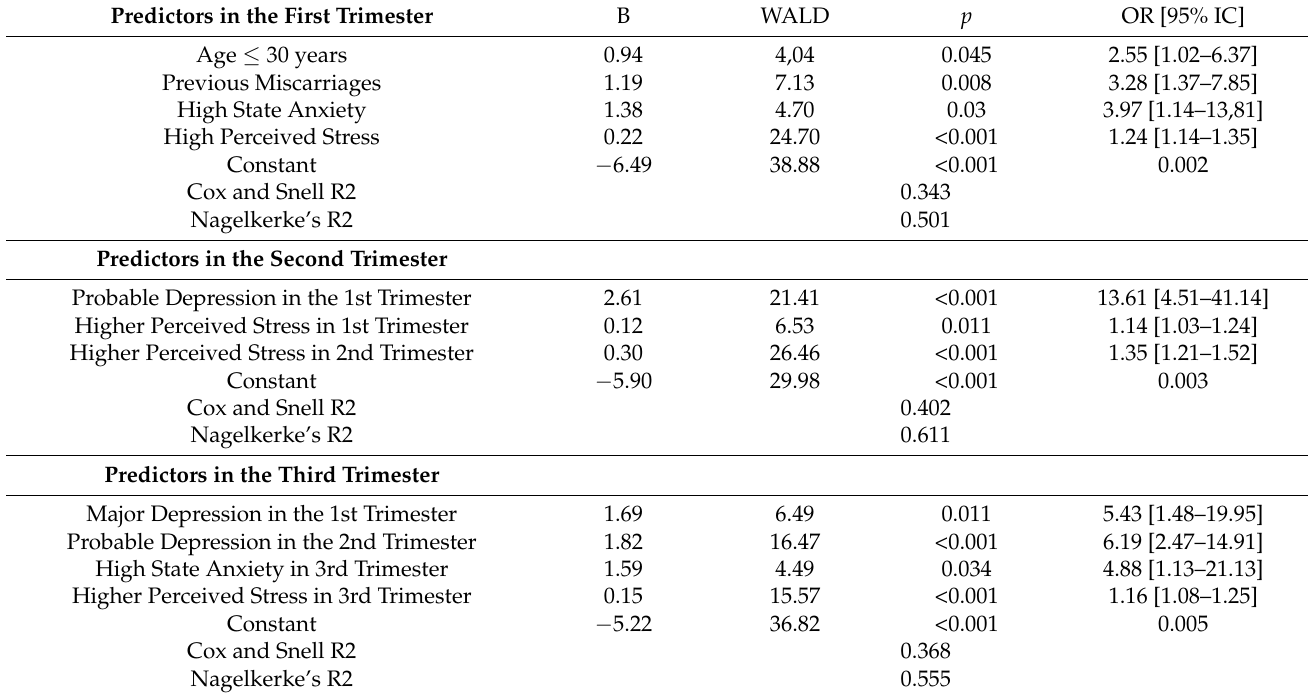
Table 4. Predictors of probable depression in each trimester.